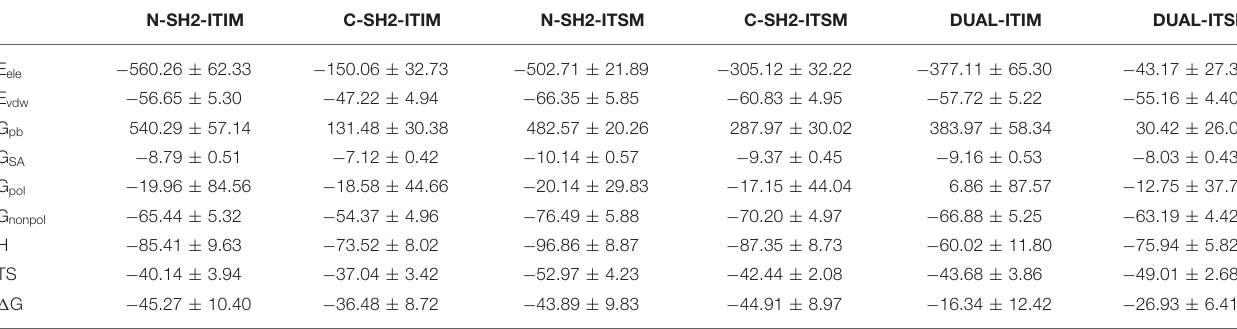
TABLE 1 | Binding free energies (kcal mol − 1 ) and its components for a complex system. N-SH2-ITIM C-SH2-ITIM N-SH2-ITSM C-SH2-ITSM DUAL-ITIM